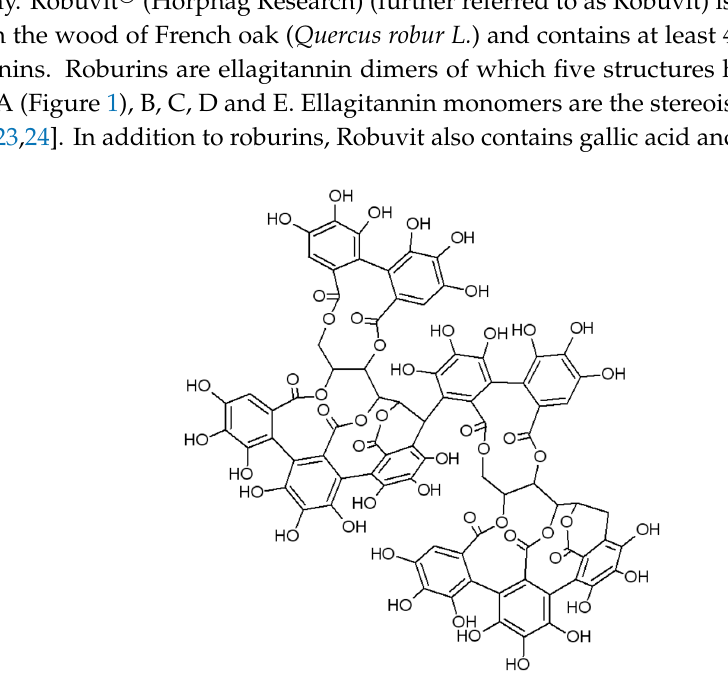
Figure 1. Chemical structure of roburin A.